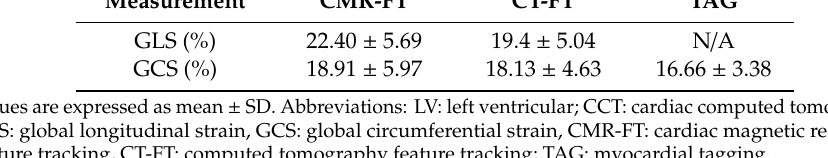
Figure 5. Bland–Altman analysis of the ( a ) GLS assessment between CT-FT and MR-FT; ( b ) GCS assessment between CT-FT and MR-FT; ( c ) GCS assessment between MR-FT and TAG; and ( d ) GCS assessment between CT-FT and TAG. Abbreviations: MR-FT: magnetic resonance feature tracking; CT-FT: computed tomography feature tracking; TAG: myocardial tagging; GLS: global longitudinal strain; GCS: global circumferential strain. 3.3. Intraobserver and Interobserver Reproducibility The results of the reproducibility analyses are presented in Table 5. Intraobserver and interobserver agreement was excellent for all techniques. CMR-FT had worse intraobserver reproducibility for GLS (LOA ±2.4% vs. ±4.36%; CoV 6.8% vs. 10.1%) but performed better in interobserver comparison (LOA ±3.16% vs. ±5.5%; CoV 7.4% vs. 16.1%). TAG had superior